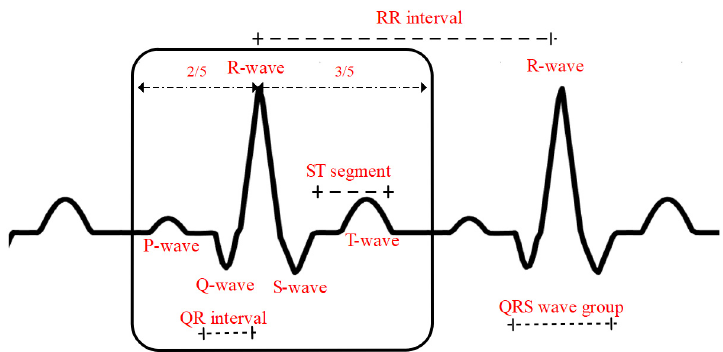
Figure 4. Schematic diagram of a standard heartbeat.